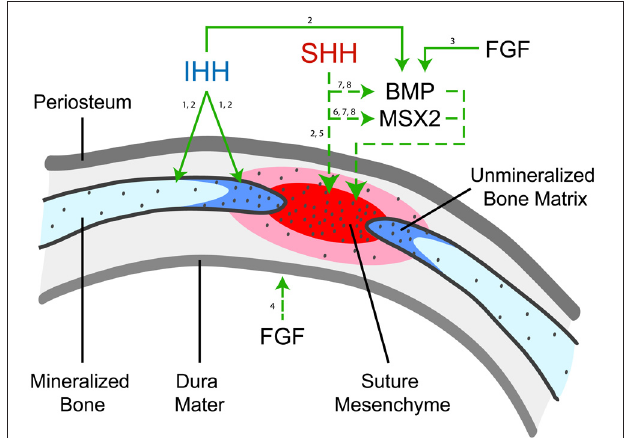
FIGURE 2 | HH Ligand expression and function in cranial suture morphogenesis. Indian Hedgehog (IHH) is observed in the cranial bones (light blue), primarily at the osteogenic front (dark blue) (1, Jacob et al., 2007; 2, Lenton et al., 2011). In this figure, solid arrows represent consistent observations while dashed arrows represent postulated pathways. Studies have shown that IHH functions to increase new bone formation at the osteogenic fronts, likely through its upregulation of BMP2 and BMP4 (2, Lenton et al., 2011). Fibroblast growth factor (FGF) has been shown to promote BMP2/4 (3, Sahar et al., 2005) and is highly expressed in dura matter and is one of the main diffusible growth factors inducing sutural fusion (4, Li et al., 2007). In contrast, SHH has been observed to be expressed in a patched pattern in the midline suture mesenchyme (shown in red), although some disagreement regarding its expression pattern exists (2, Lenton et al., 2011). The function of SHH is less clear, although it has been postulated to function in maintaining suture patency (5, Kim et al., 1998). SHH may increase mesenchymal proliferation and suture mesenchyme thickness via promotion of MSX2 (6, Alappat et al., 2003), and similarities are present between the expression of SHH, MSX2, and BMP expression during neonatal craniofacial suture development (7, Liem et al., 2000; 8, Santagati and Rijli,